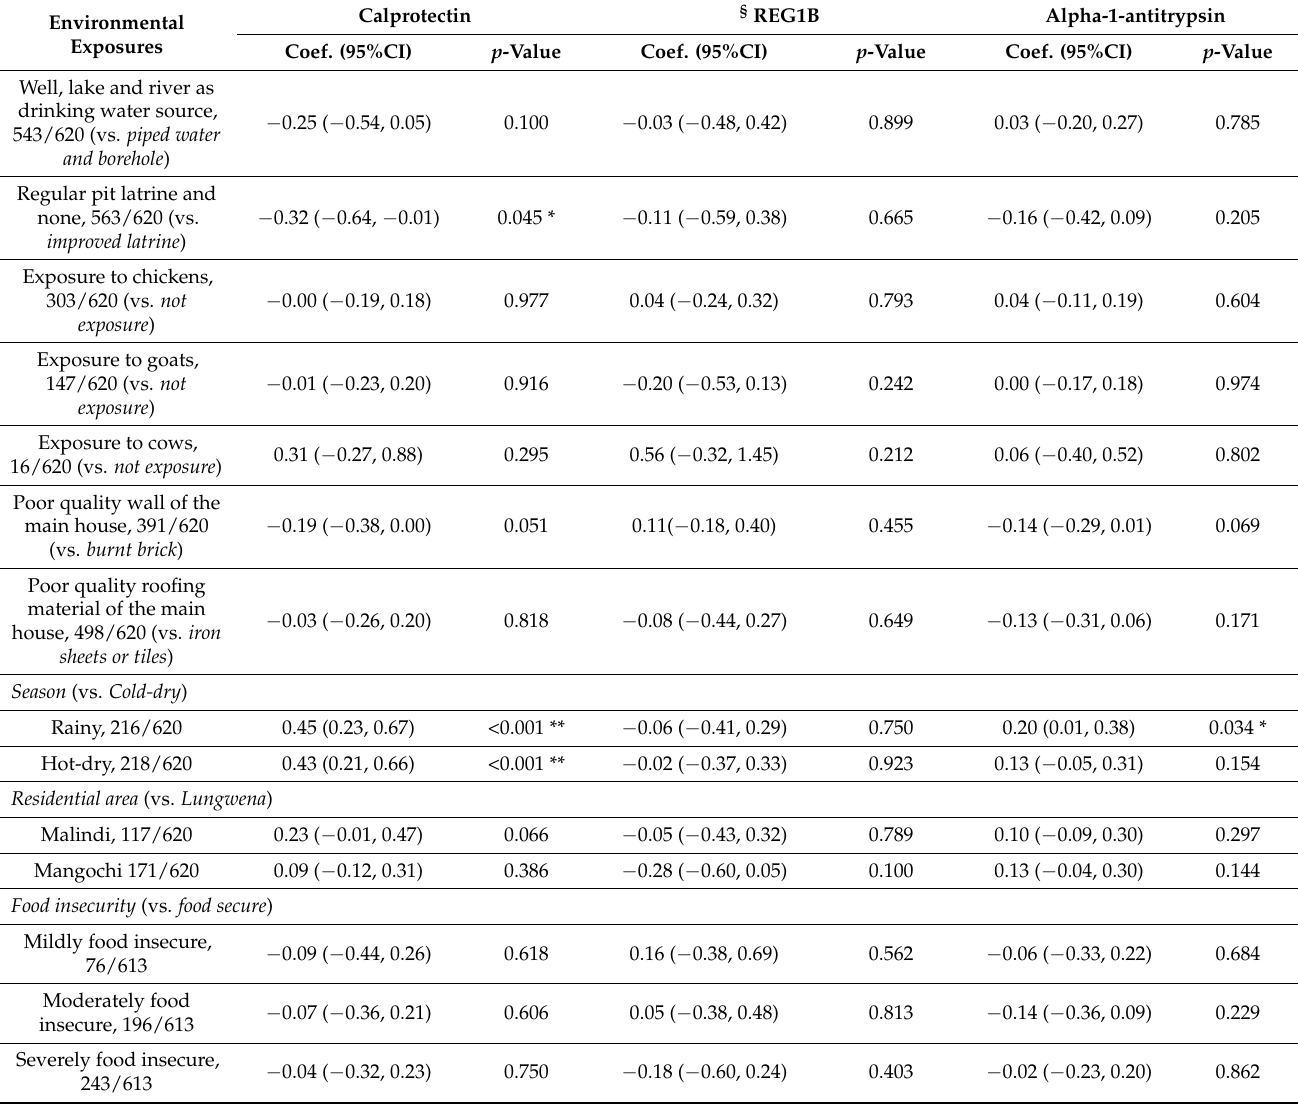
Table 2. Associations between environmental exposures and intestinal biomarkers in bivariate analysis †